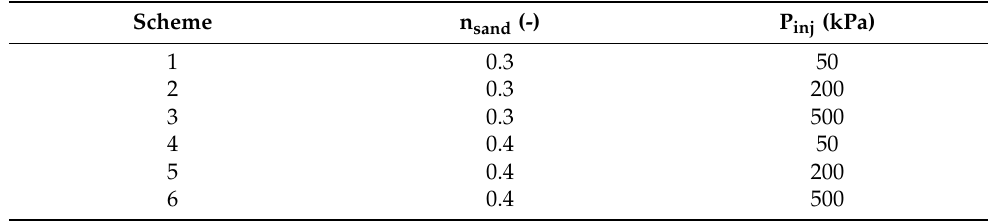
Table 3. Numerical simulation